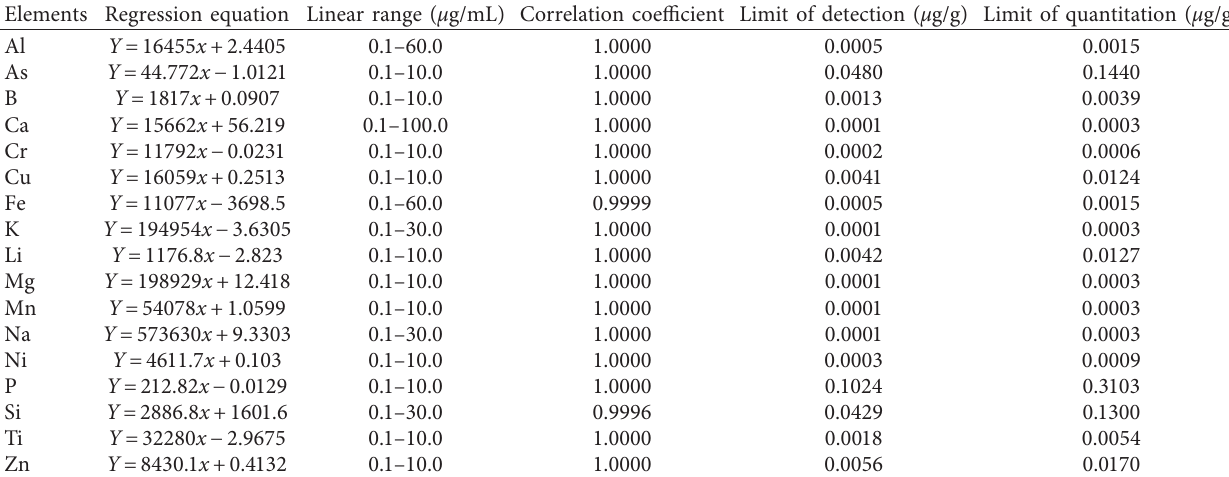
Table 4: Linear correlation and ranges and limits of trace elements reference